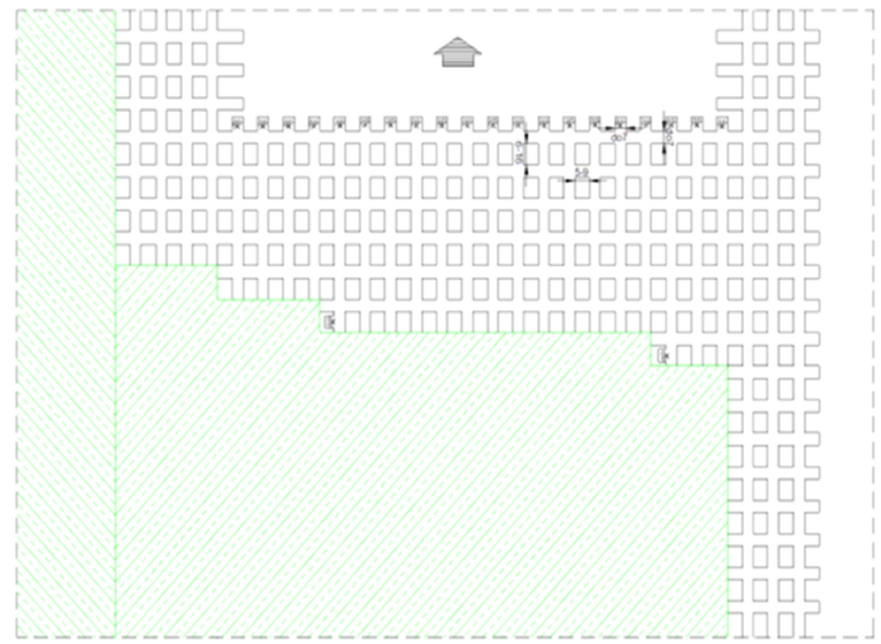
Figure 4. Room and pillar mining system with roof deflection J-UG-PS [42].